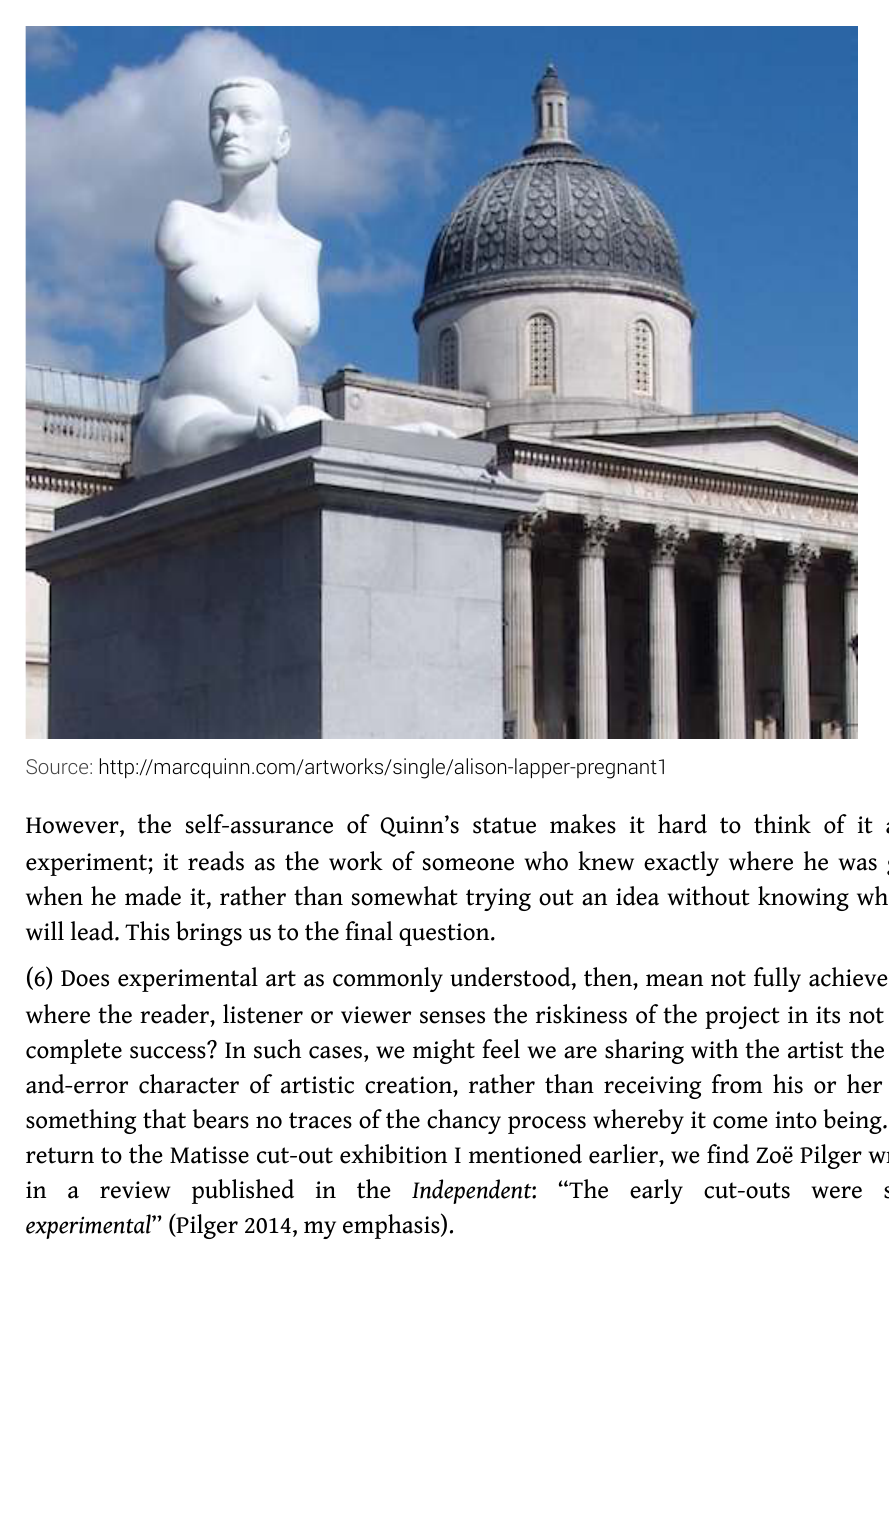
Figure 4. Marc Quinn, Alison Lapper Pregnant